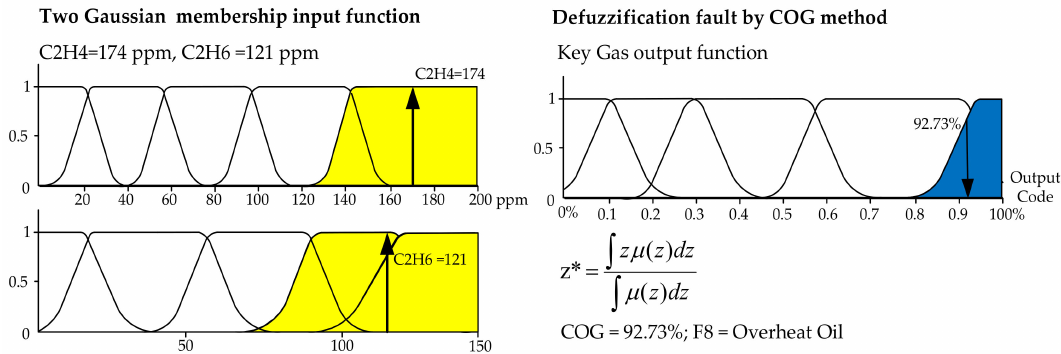
Figure 3. Two-gaussian membership function fuzzification and defuzzification for key gas